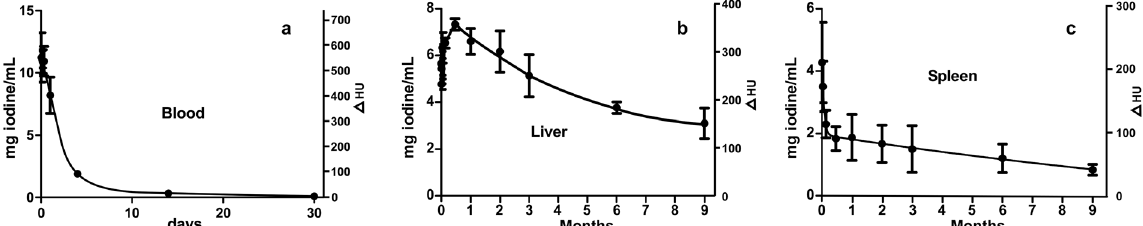
Figure 6. Blood, liver, and spleen iodine content after an IV injection of 1.75 g iodine/kg INPs. The mg iodine/ mL in the tissue is shown on the left axes and the increase in tissue radiodensity ( Δ HU = increase in Hounsfield units) is shown on the right axes. Three mice per point were averaged showing the standard error of the mean.